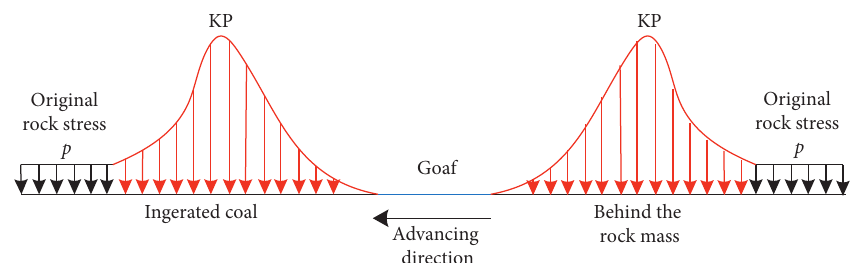
Figure 3: Distribution of mining stress.